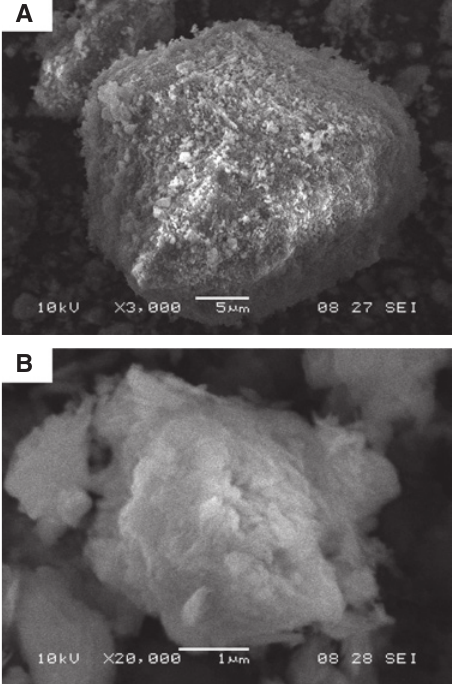
Figure 3 SEM images of (A) the unmodified zeolite and (B) the modified